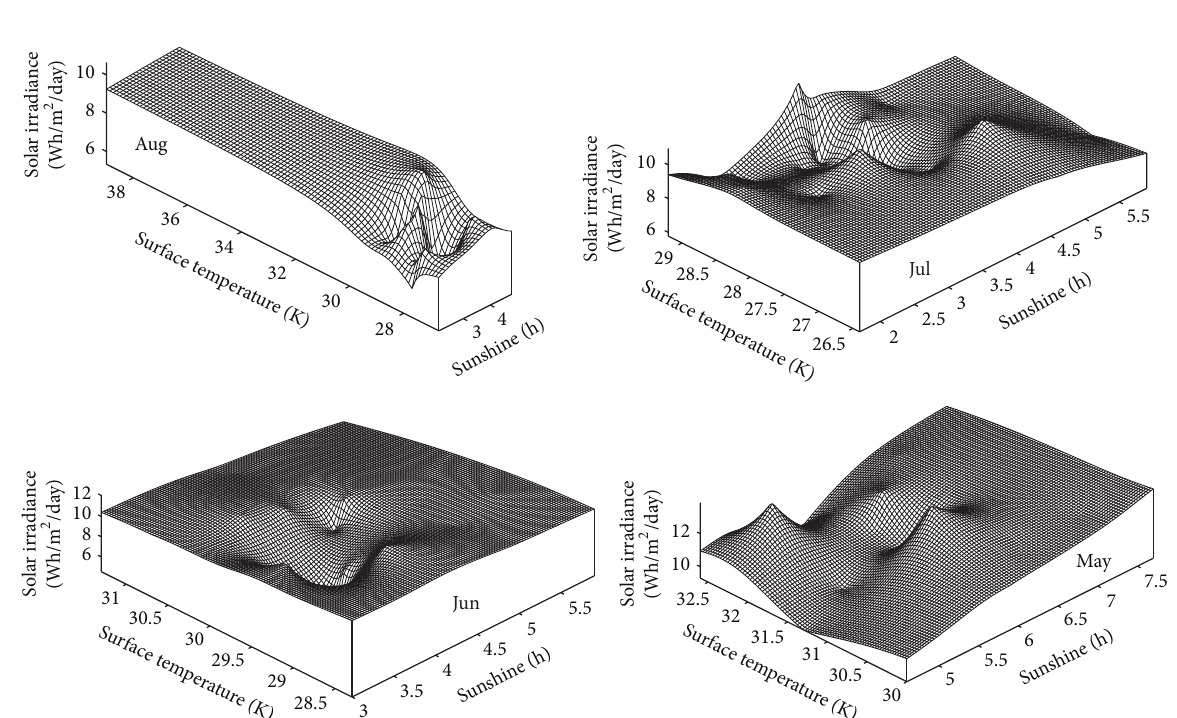
Figure 6: Weather parameter trend for